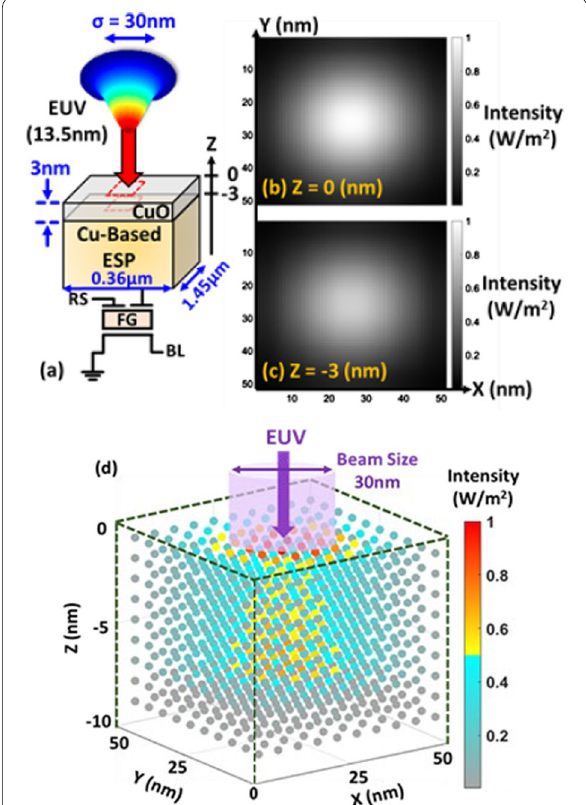
Fig. 4 a The FDTD simulation setup and the 2D intensity distribution